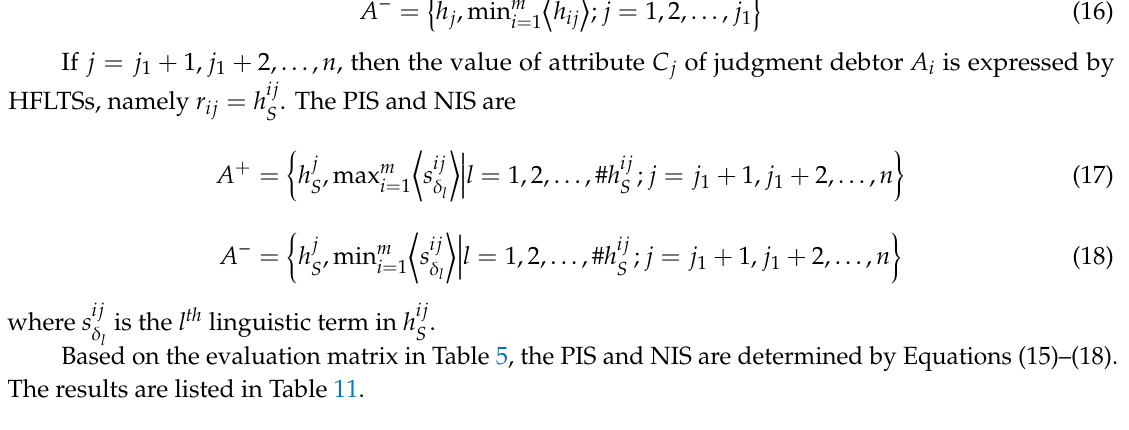
Table 11. The PIS and NIS of judgment